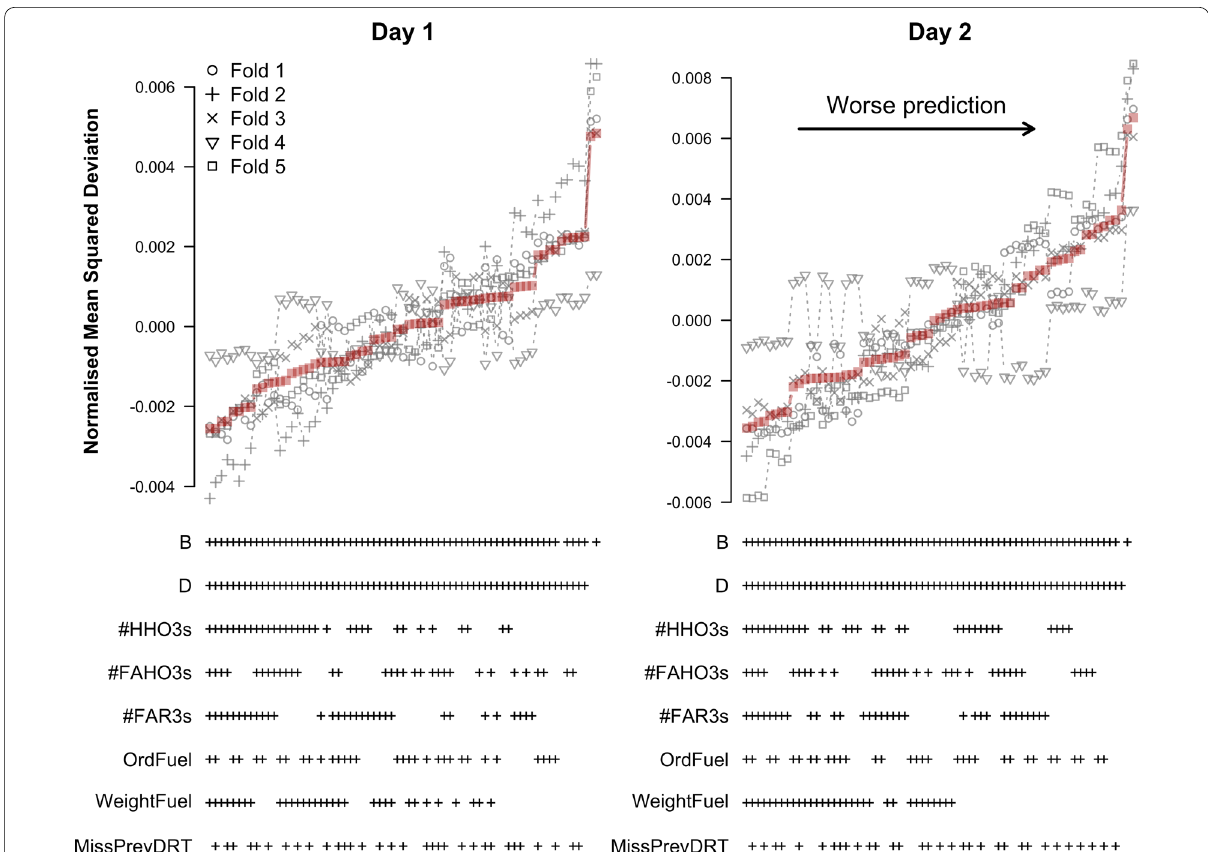
Fig. 10 Cross-validation results for predicting log-RT with a log-normal TPM based on refined predictors